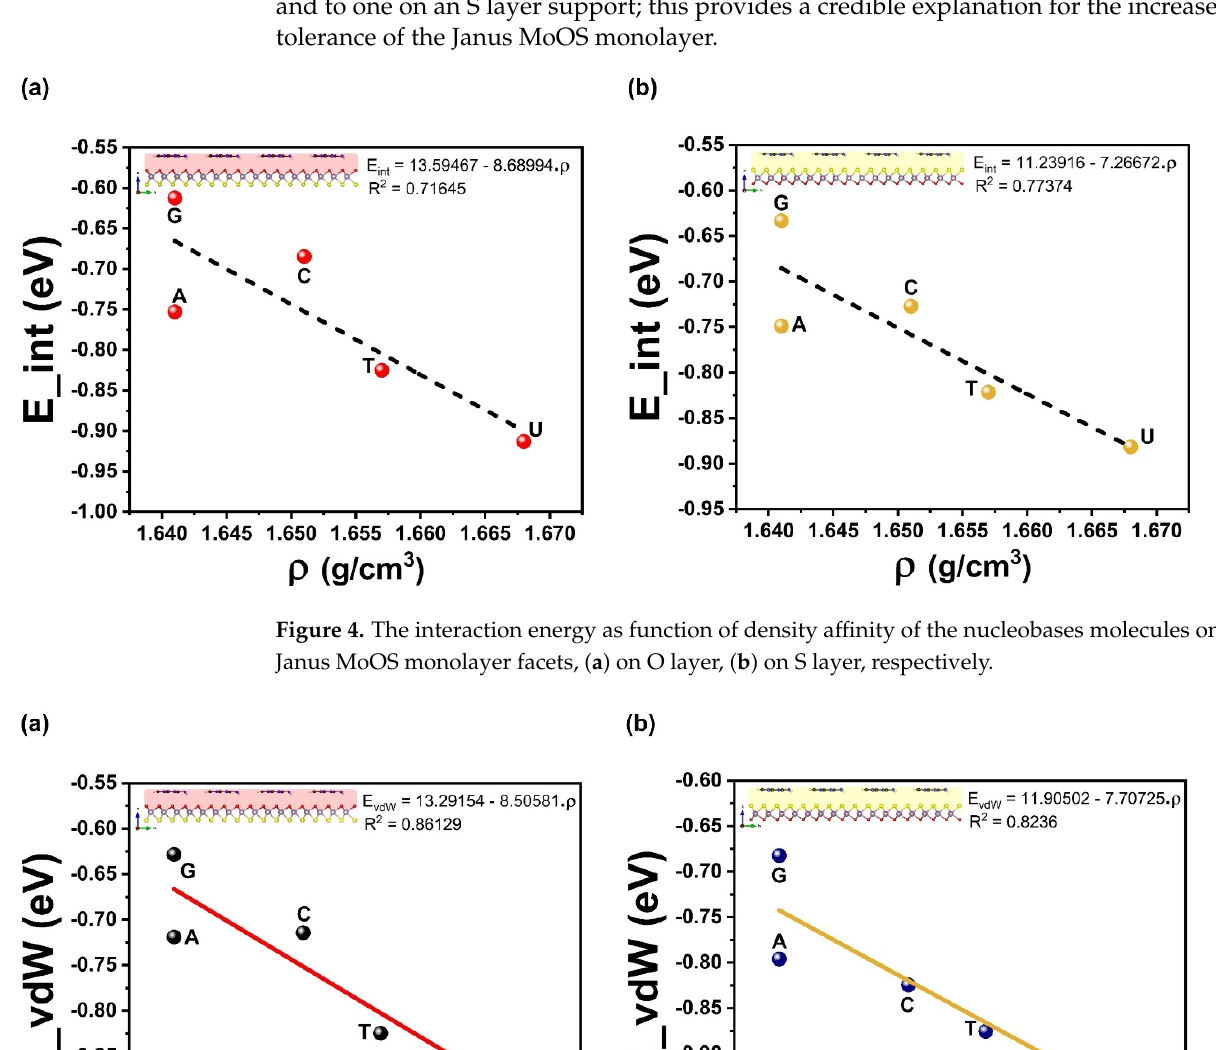
Figure 6. Hirshfeld-I electronic charge as function of interaction energy of the nucleobases molecules on the Janus MoOS monolayer facets, ( a ) on O layer, ( b ) on S layer, respectively.